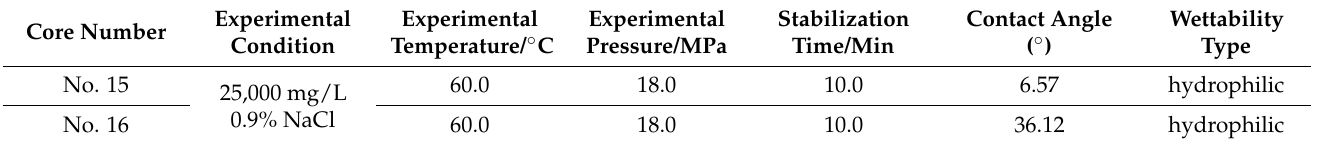
Table 3. Results of the wettability tests for the studied rock